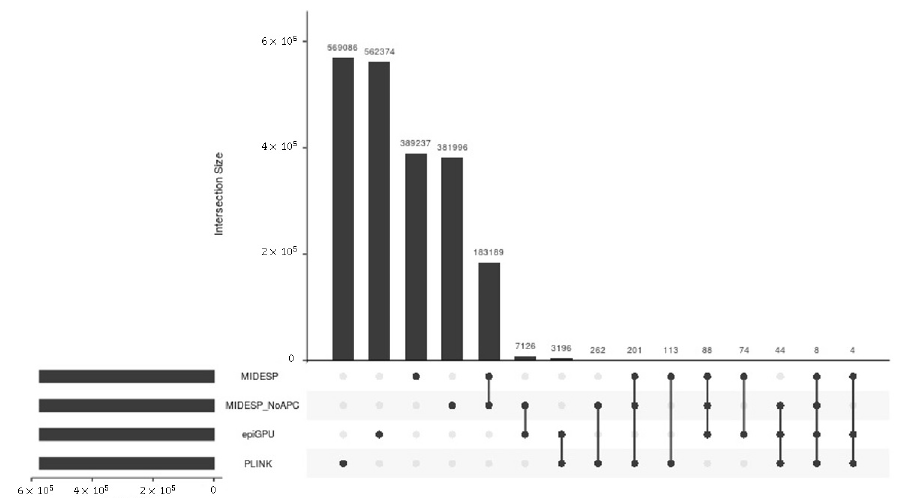
Figure 10. Number of epistatic SNP pairs detected for the EW dataset and their overlap between four methods represented in matrix layouts using the UpSet technique [121]. Black circles in the matrix layout indicate which methods are part of the